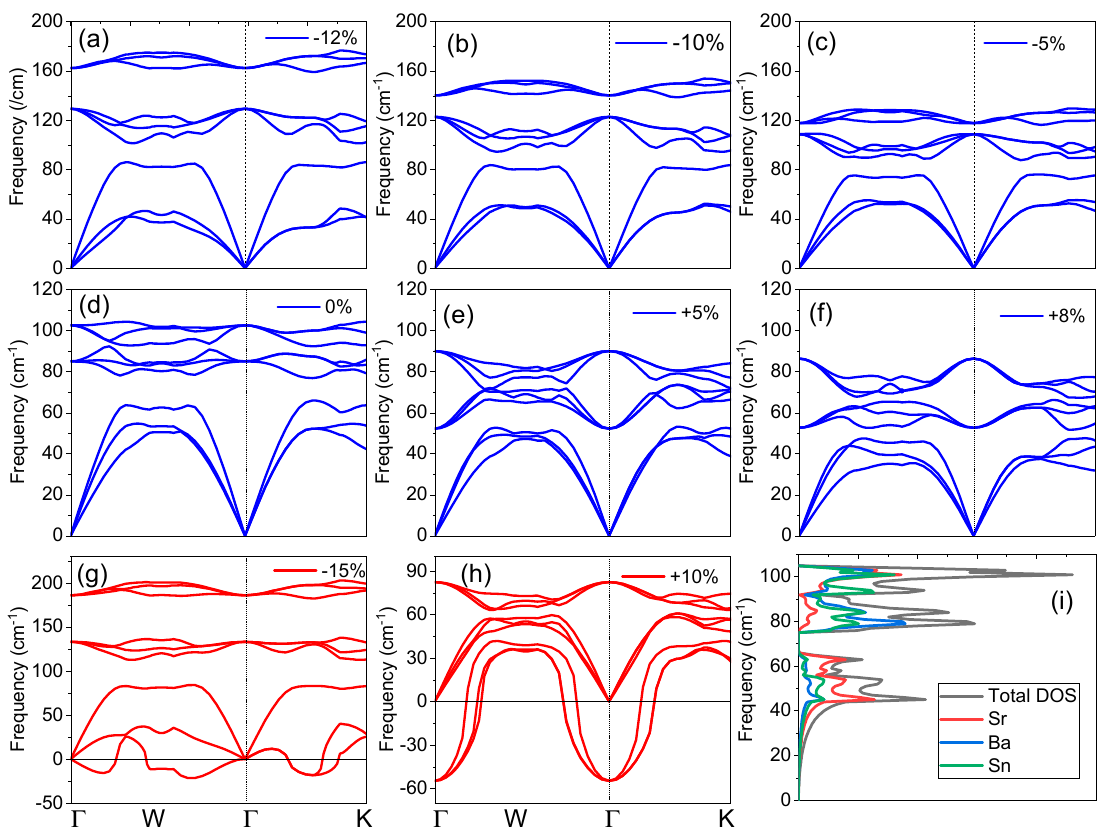
Figure 2. Phonon dispersion of SrBaSn at equilibrium and after strain application. ( a – c ) Compressive strain; ( d ) at equilibrium ground state ( e , f ) expansive strain; ( g , h ) represent unstable structures; ( i ) total and partial phonon density of states from each atom.